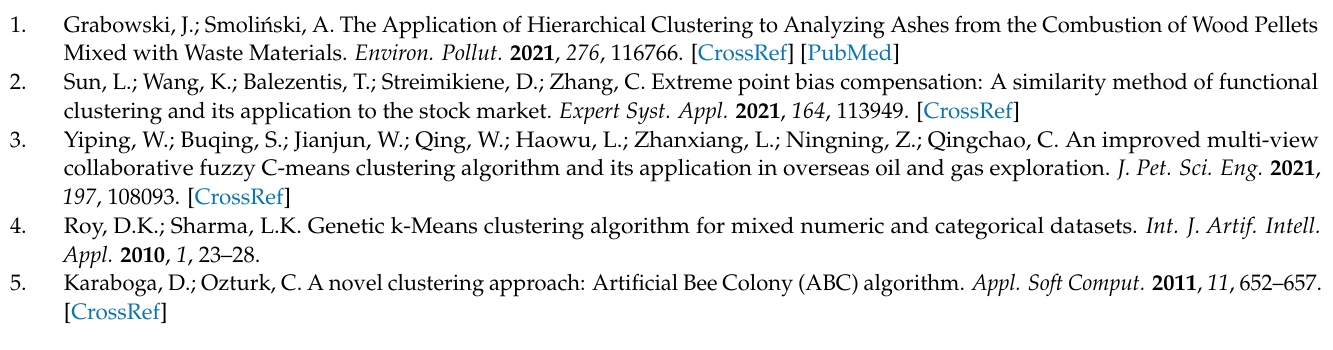
different iteration number; Table S2: Cluster error results of the CFA algorithm, with different iteration number, Table S3: Cluster error results of the CNBA algorithm, with different iteration number, Table S4: Cluster error results of the CABC algorithm, with different population sizes, Table S5: Cluster error results of the CFA algorithm, with different population sizes, Table S6: Cluster error results of the CNBA algorithm, with different population sizes, Table S7: Cluster error results of the CABC algorithm, with different fitness functions, Table S8: Cluster error results of the CFA algorithm, with different fitness functions; Table S9: Cluster error results of the CNBA algorithm, with different fitness